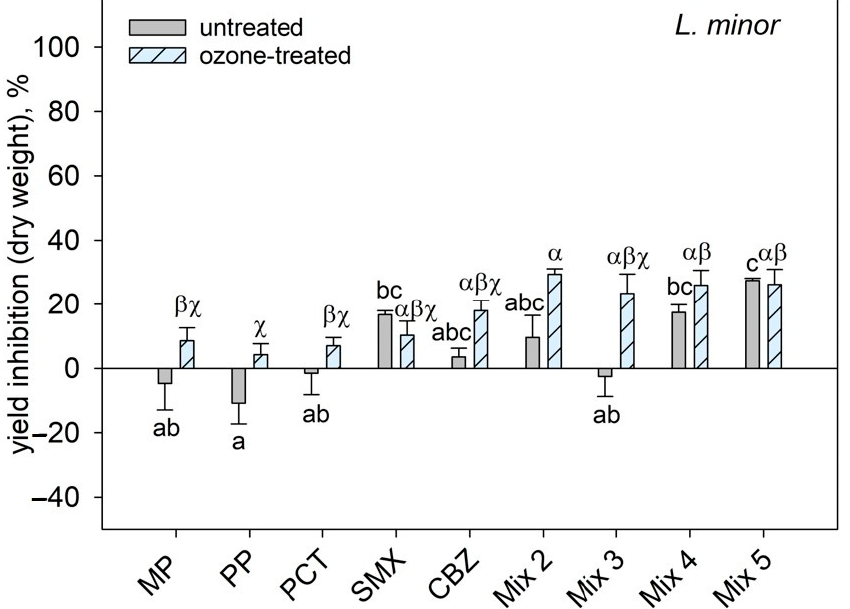
Figure 5. The yield inhibition of Lemna minor after 7d of exposure to untreated and ozone-treated solutions, expressed as dry weight. The bars represent the mean, and the error bars represent the standard error of the mean. Mix 2: MP+PP; Mix 3: MP+PP+PCT; Mix 4: MP+PP+PCT+SMX; Mix 5: MP+PP+PCT+SMX+CBZ. The different Latin letters indicate significant differences among untreated samples; different Greek letters indicate significant differences among ozone-treated samples.